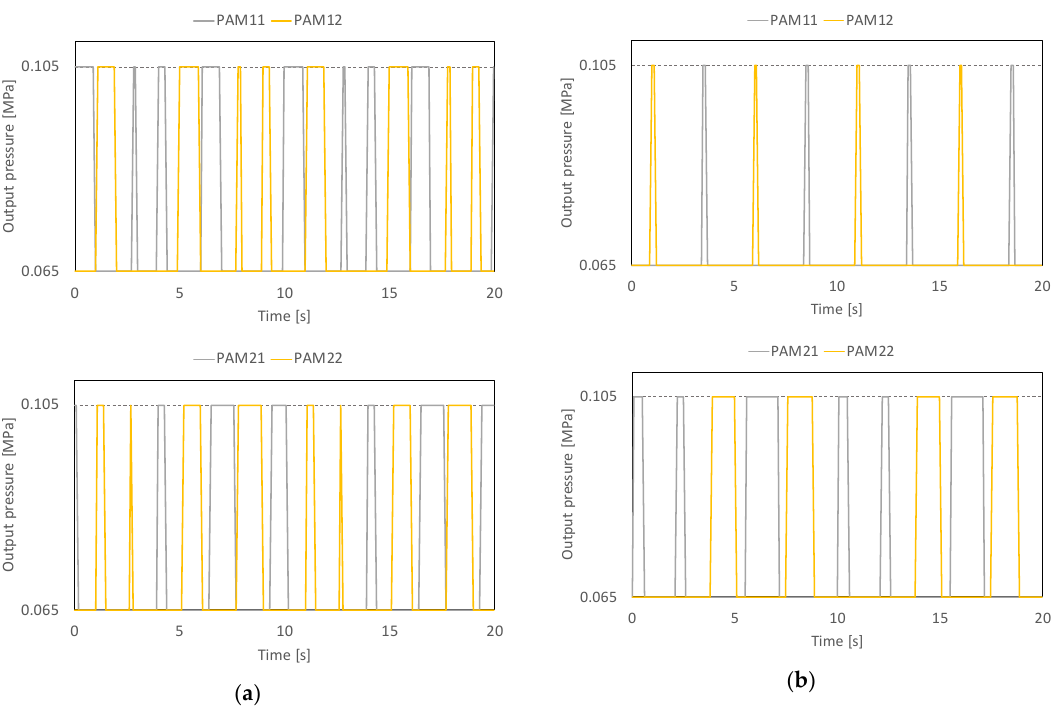
Figure 13. Cyclic inputs of PAMs using evaluation function 2 without load (( a ) first generation, ( b ) 18th generation).